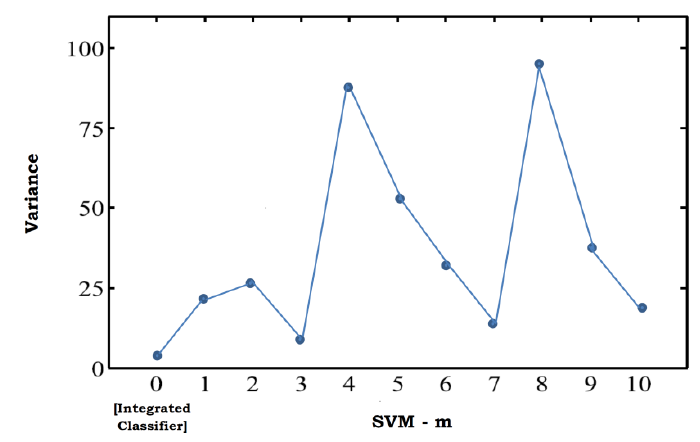
Figure 9. Receiver operating characteristic curve for the proposed model.